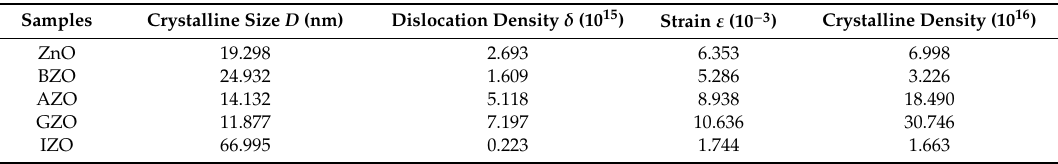
Table 3. The structure parameters of undoped ZnO and group III elements (B, Al, Ga, and In)-doped ZnO thin films at 3% doping